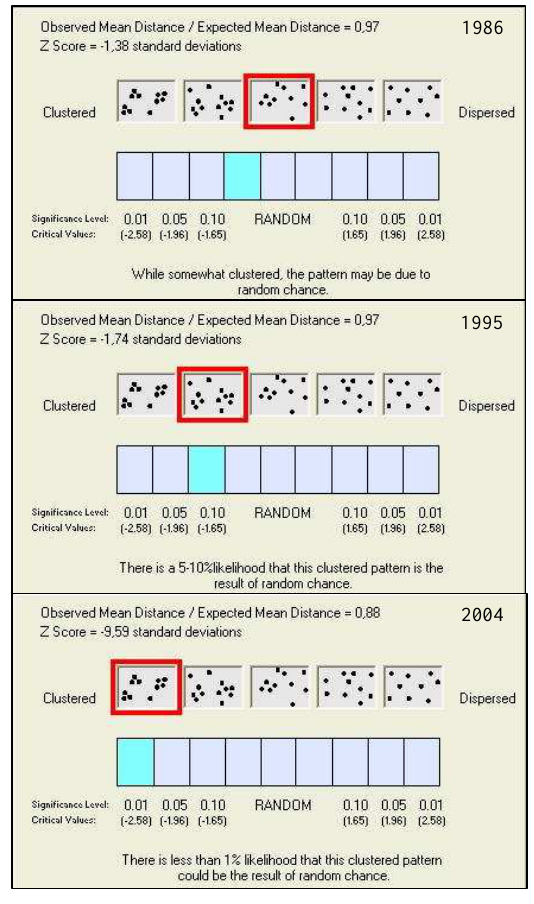
Figure 13: Voronoi nearest neighbour index expressed the ratio of the observed distance divided by the expected